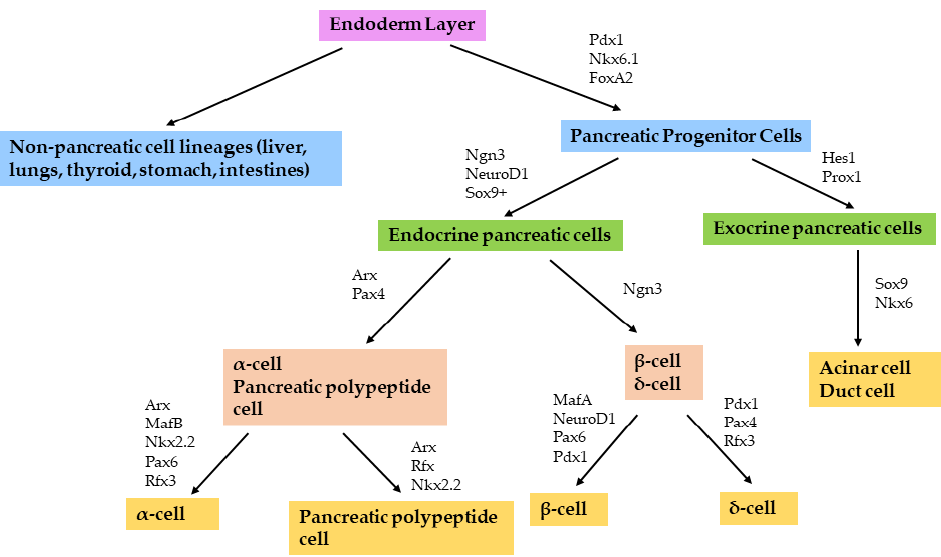
Figure 1. Representation of the hierarchy of the human pancreatic transcription factors involved in the development and differentiation of pancreatic cells. FoxA2 is present in the pancreatic buds, which develop from the endodermal layer. Pdx1 allows the development of the pancreas and differentiation of pancreatic cells through interaction with other transcription factors: Hes1 and Prox1 to non-endocrine cell lineages and Ngn3, NeuroD1 and Sox9 + to endocrine cells. Pax4 and MafA then are thought to mediate the direct differentiation to the β-cell phenotype. The α-cells, β-cells and δ-cells secrete glucagon, insulin and somatostatin, respectively. The pancreatic polypeptide cells secrete pancreatic polypeptide which regulates the secretory activity of the pancreas.